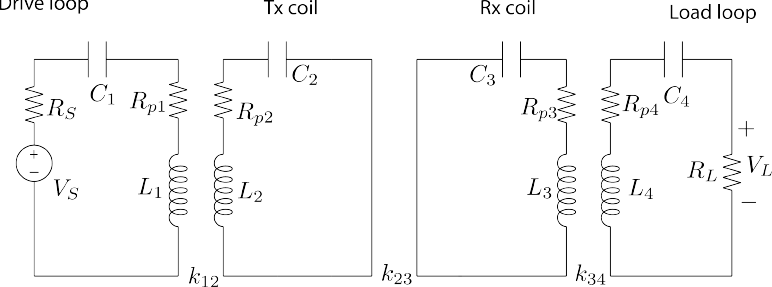
Figure 1. Four coils lumped equivalent circuit.